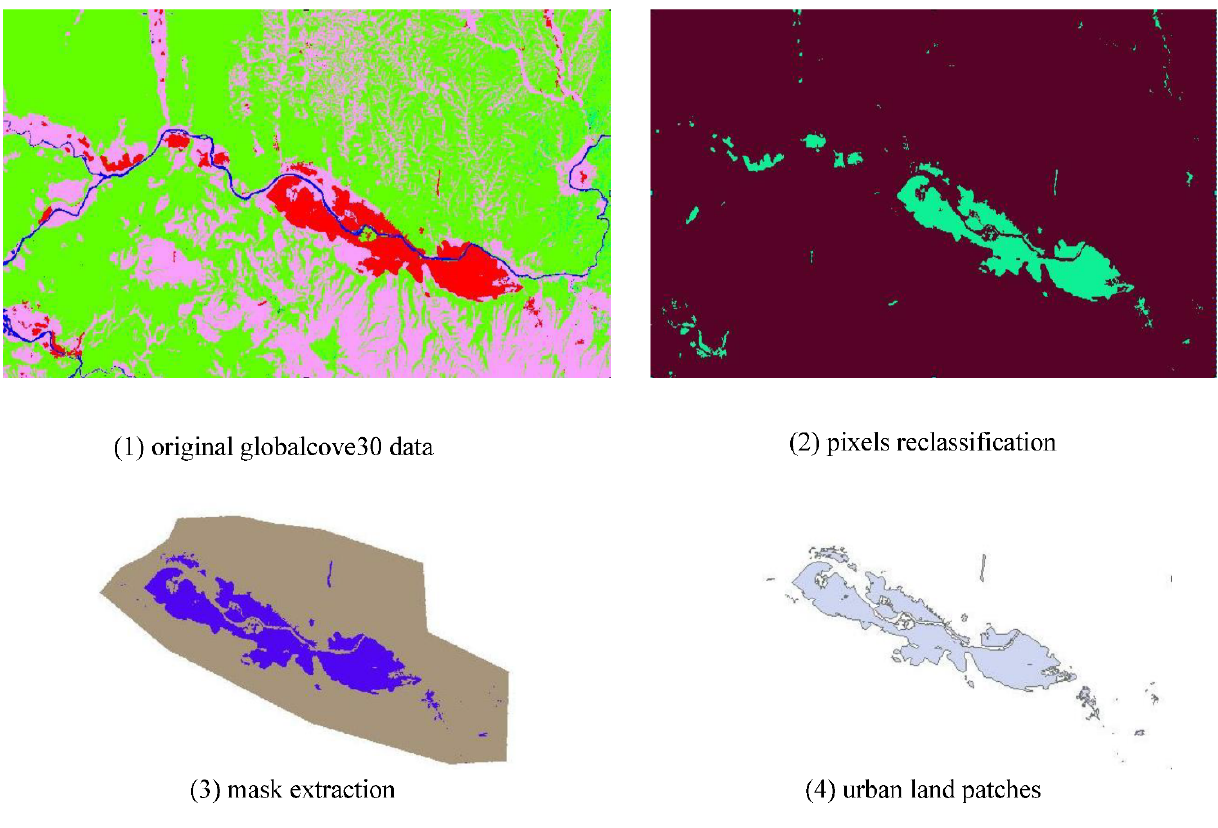
Figure 2. Urban geometric form process.